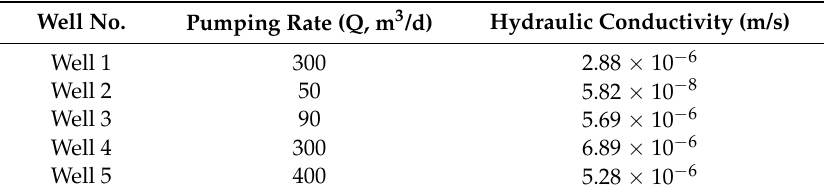
Table 3. Long- term pumping test result.